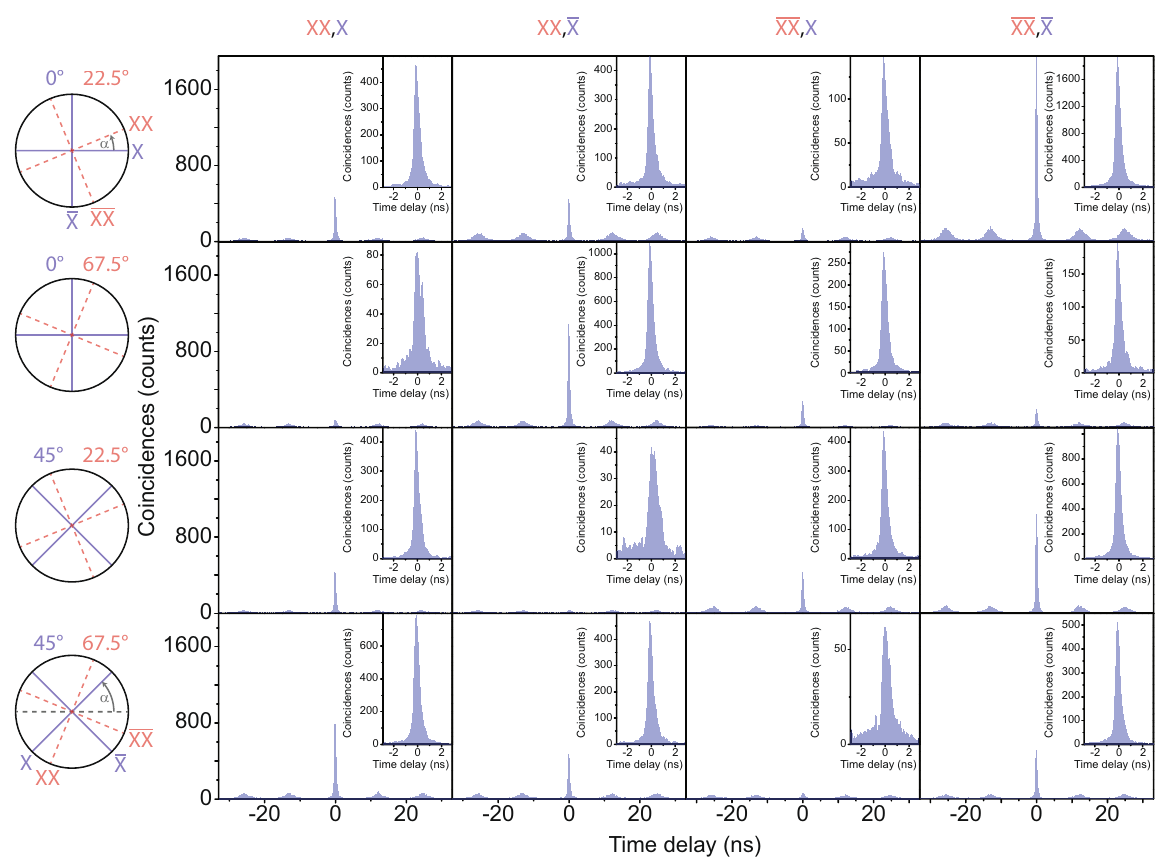
ton (X and X ) photons. The degree of correlation C b in one polarization basis b is extracted from the polarization dependent cross-correlation measurements (shown in Fig. 3):